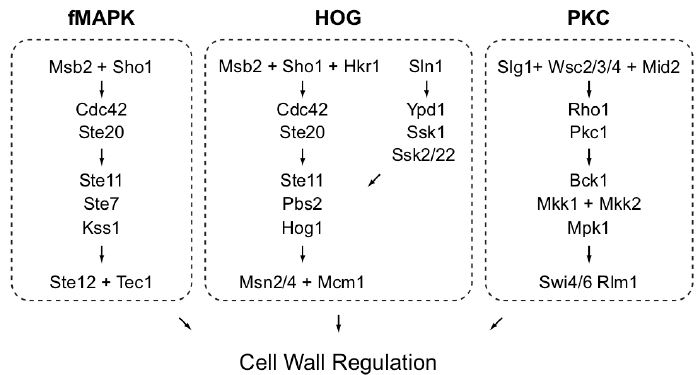
Figure 1. MAPK pathways that can regulate the cell wall in yeast. Not all proteins are shown, adapted from [77].